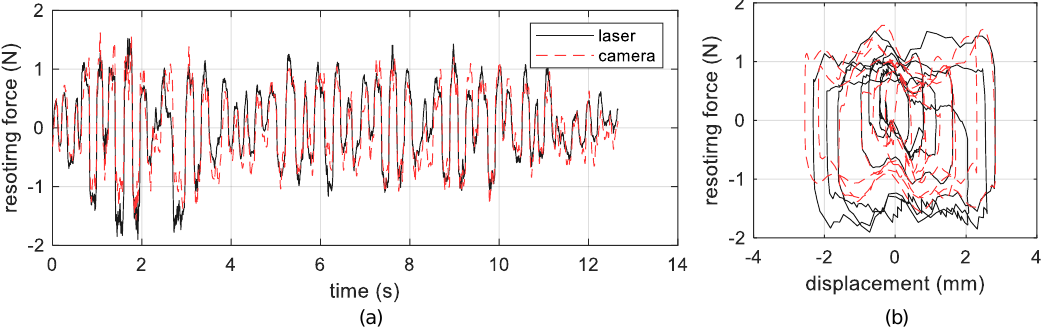
Figure 15. Frictional force F computed by the measured displacement and acceleration data: ( a ) time history of F , ( b ) u 0 vs. F .